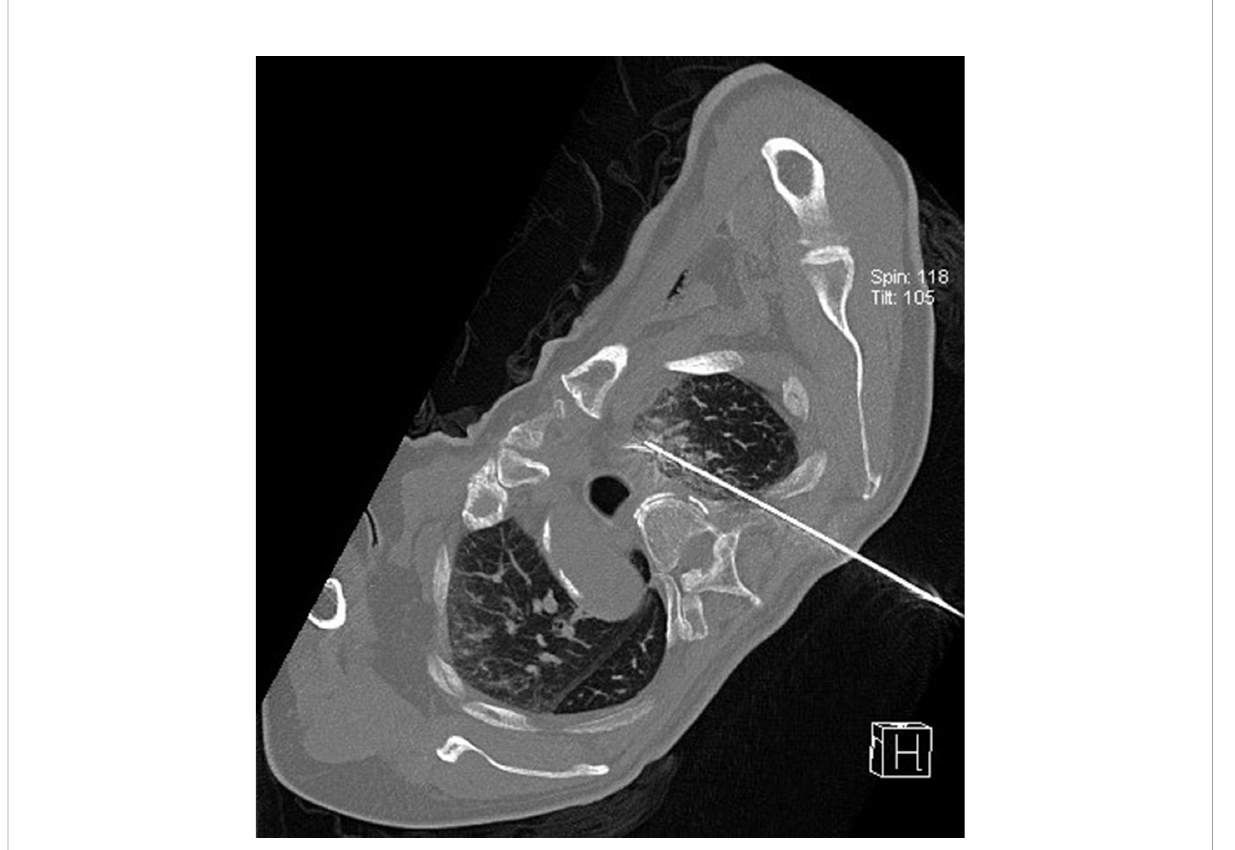
FIGURE 8 Intraoperative scan: the Reconstructed CT image.